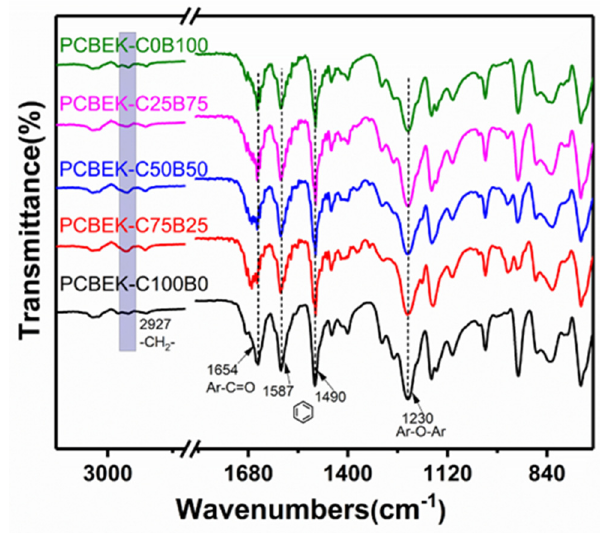
Figure 1. FT-IR spectra of PCBEKs series polymers.